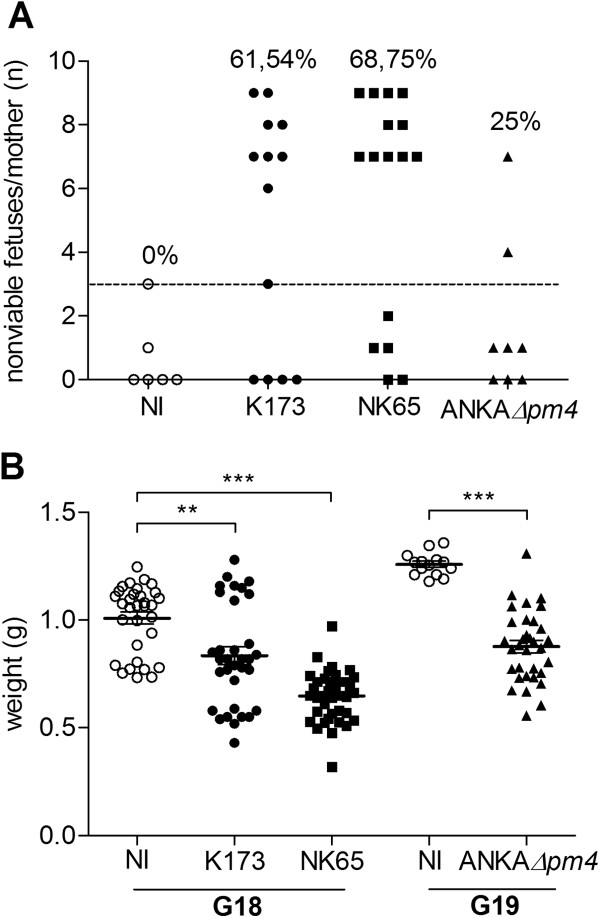
Stillbirths and underweight foetuses as consequence of infection. C57BL/6 pregnants were infected i.v. on G13 (K173 or NK65) or on G10 (ANKAΔpm4) with 106 IE. Number of stillbirths (dead foetuses and/or reabsorptions) per mother in utero (A) and viable and non-viable foetuses weight (B) were accessed at G18 or G19. **p<0.01; ***p<0.001; NI: non-infected. Cut-off for non-viability was established in non-infected pregnant mice (dashed line).